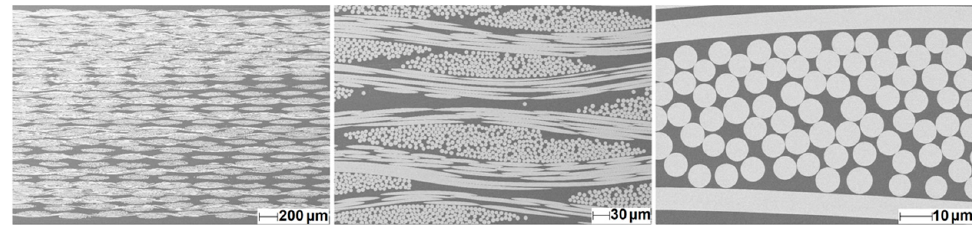
Figure 7. SEM images showing the cross-section of the 29 layers composite in different magnifica- tions to evaluate the infiltration quality of the resin.